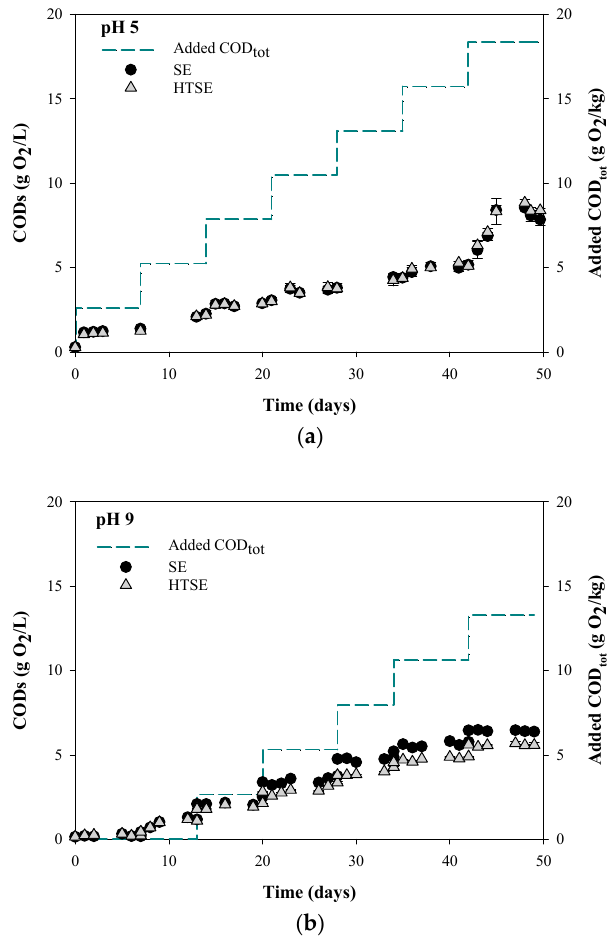
Figure 1. Solubilisation of SE and HTSE organic matter in COD ( a ) at a pH of 5 and ( b ) at a pH of 9 with respect to feed.